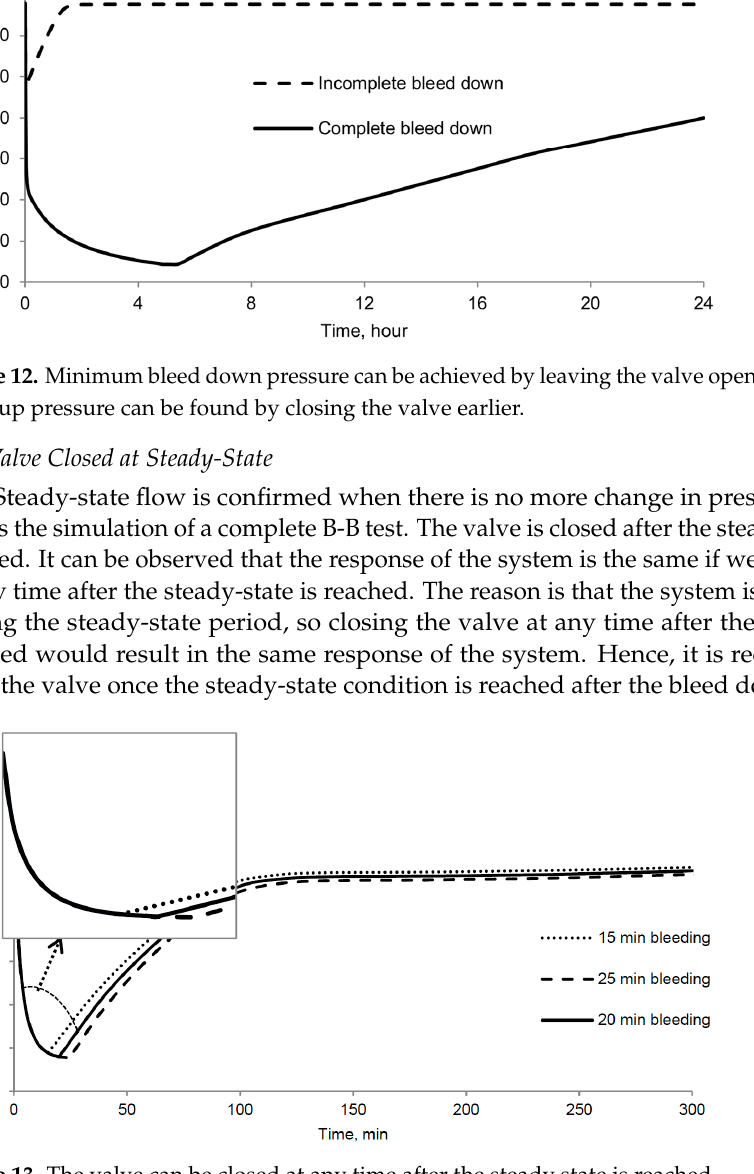
Figure 13. The valve can be closed at any time after the steady state is reached.